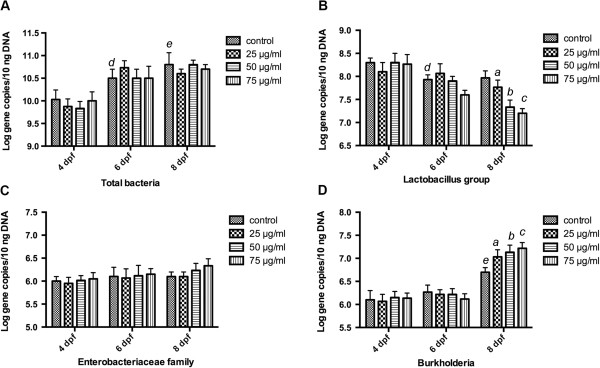
Quantitative analysis of characteristic bacterial species. The relative quantity of specific groups of bacteria was determined by real-time PCR of 16S rRNA gene of (A)Total bacteria, (B)Lactobacillus group, (C)Burkholderia and (D)Enterobacteriaceae family. All reactions were performed in triplicate. Specific bacteria 16S rRNA gene amount was normalized to total bacteria 16S rRNA. Quantification values were represented as mean ± SEM log 16S rRNA gene copies per 10 ng of bacterial genomic DNA. aIndicates a significant difference (p<0.05) between TNBS-exposed group (25 μg/ml) and the control, bIndicates a significant difference (p<0.05) between TNBS-exposed group (50 μg/ml) and the control, cIndicates a significant difference (p<0.05) between TNBS-exposed group (75 μg/ml) and the control, dIndicates a significant difference (p<0.05) between control groups at 6 dpf and 4 dpf, eIndicates a significant difference (p<0.05) between control groups at 8 dpf and 4 dpf.